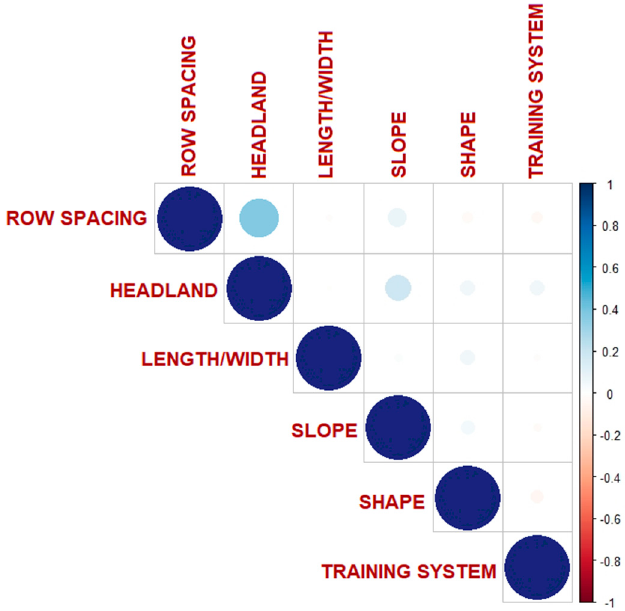
Figure 3. Correlogram of the contributing variables. Positive correlations are displayed in blue and negative correlations in red. Colour intensity is proportional to R 2 , while the magnitude of the circles is proportional to p -value.